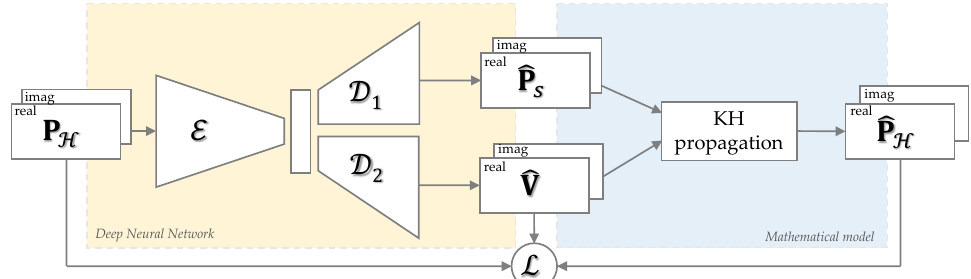
Figure 3. Overall scheme of the proposed KHCNN model. The CNN architecture (yellow block) predicts the real and imaginary parts of two outputs are then propagated with the KH model in order to obtain the estimate of loss function is built on top of the velocity ground truth and the pressure at the